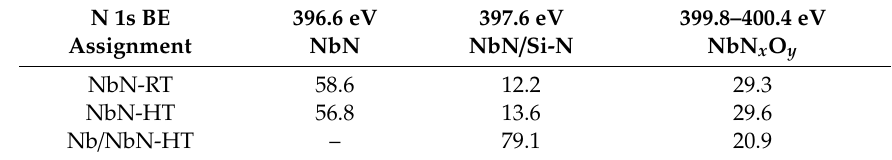
Table 6. XPS curve-fitting results of N 1s spectra (total peak area = 100%).